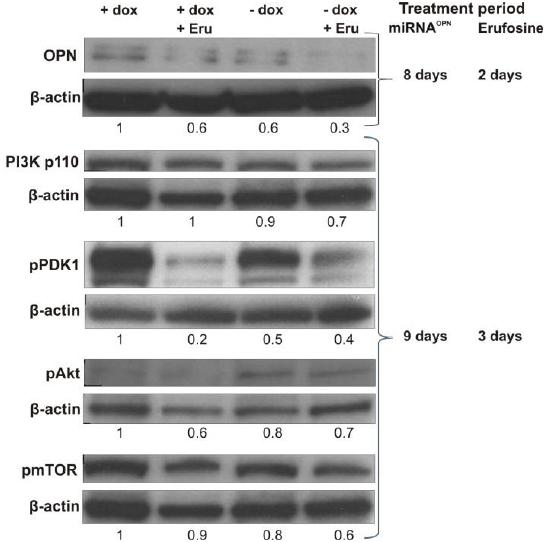
Figure 6. Effects of conditional OPN knockdown and exposure to erufosine alone or in combination on some PI3K/Akt pathway proteins in MDA-MB-231-derived breast cancer cells. Cells from the O2 cell clone were cultivated continuously in medium with doxycycline and were used as control (+dox) or were exposed to erufosine for 48 to 72 h (+dox + Eru). O2 cells were also cultivated in medium